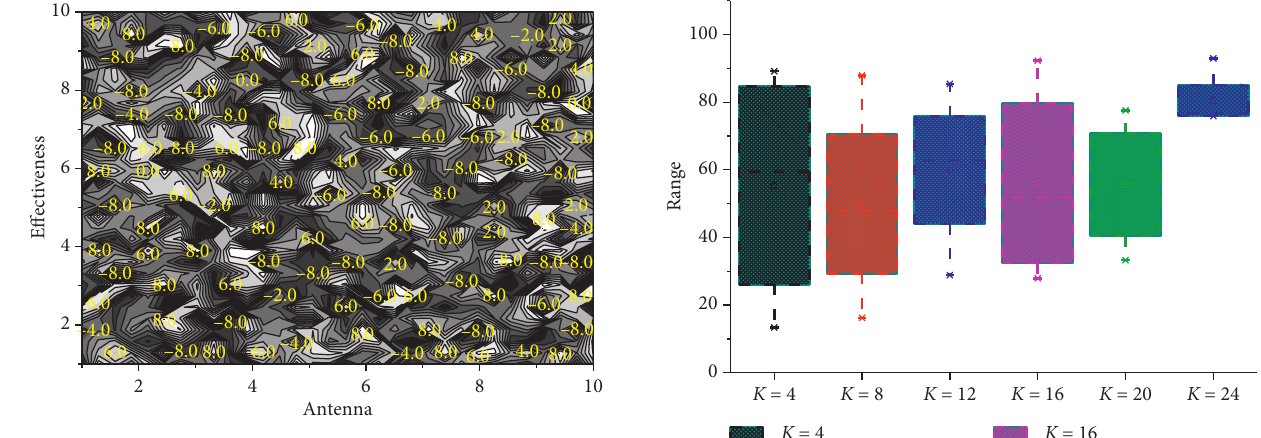
Figure 7: Spectral efficiency vs. the number of antennas in a 16 × 16 mm wave MIMO system.